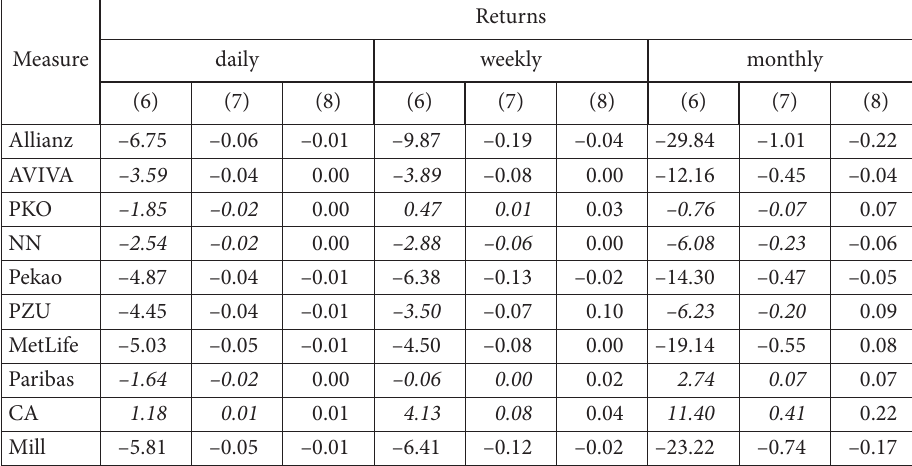
Table 16. Average values of Sharpe, Treynor and Jensen efficiency ratios evaluated for mutual funds for period e (source: own calculations) Returns Measure daily